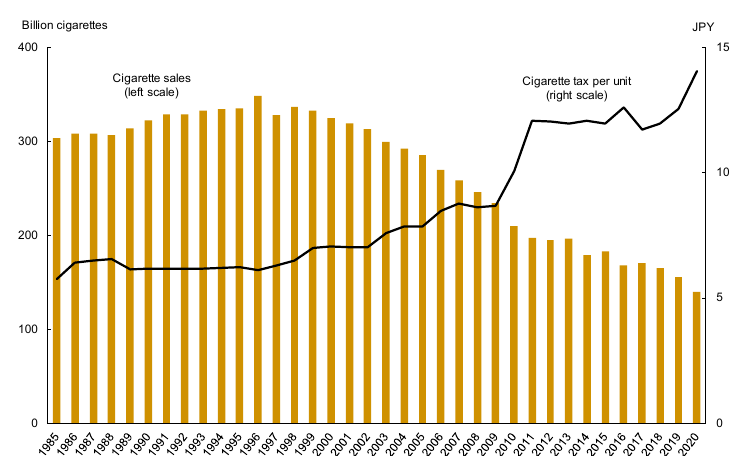
Figure 1. Trends in cigarette sales and cigarette tax per unit.